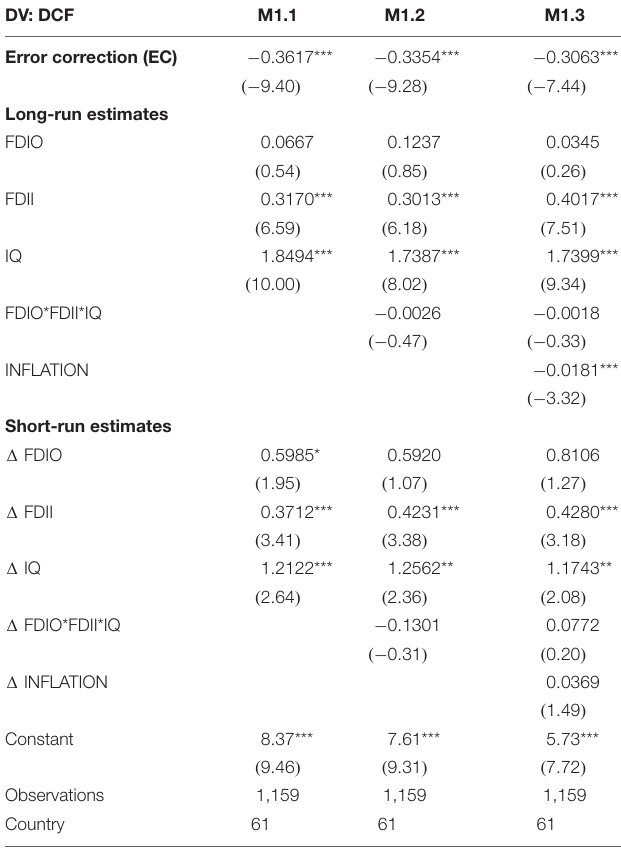
TABLE 6 | The impact of FDII, FDIO, and IQ on